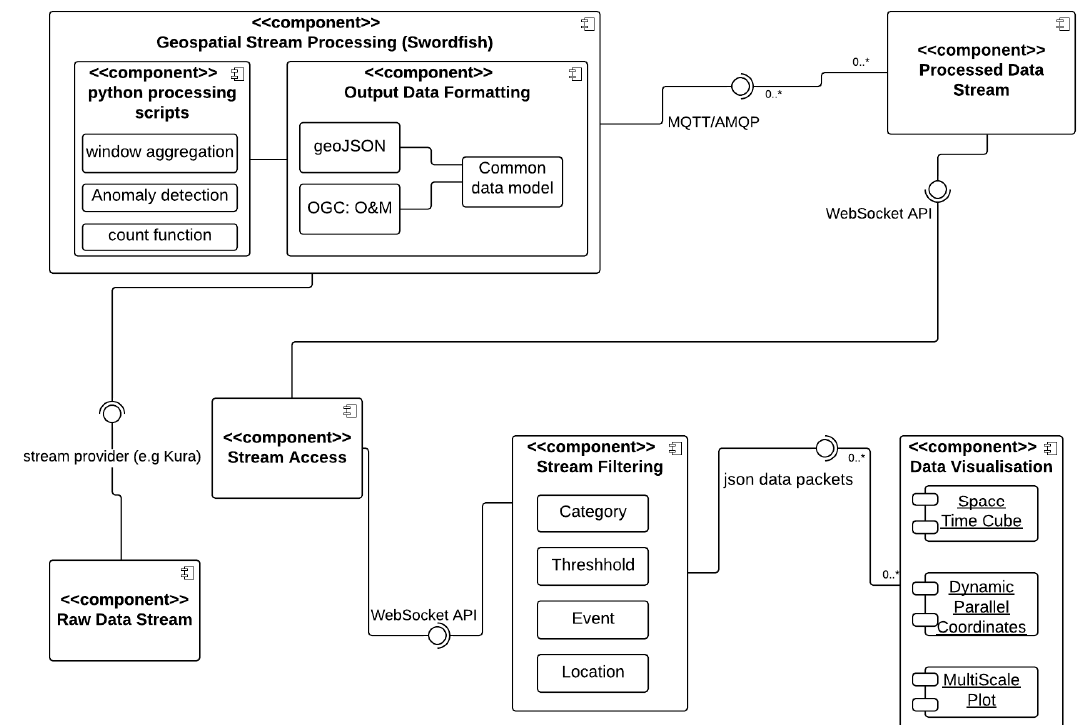
Figure 10. An illustration of the components of the geoStreamViewer application.